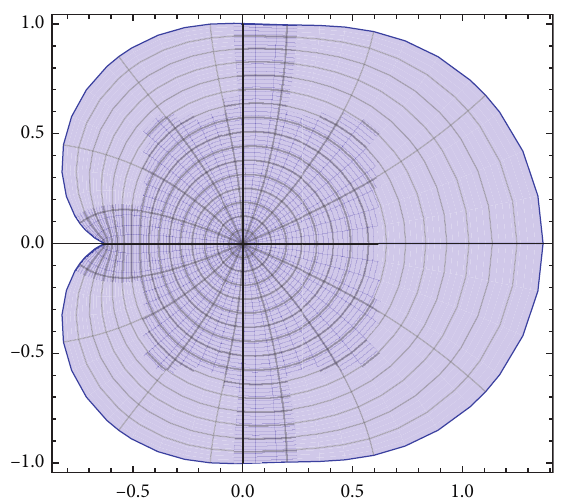
Figure 3: Image of D under the mapping h